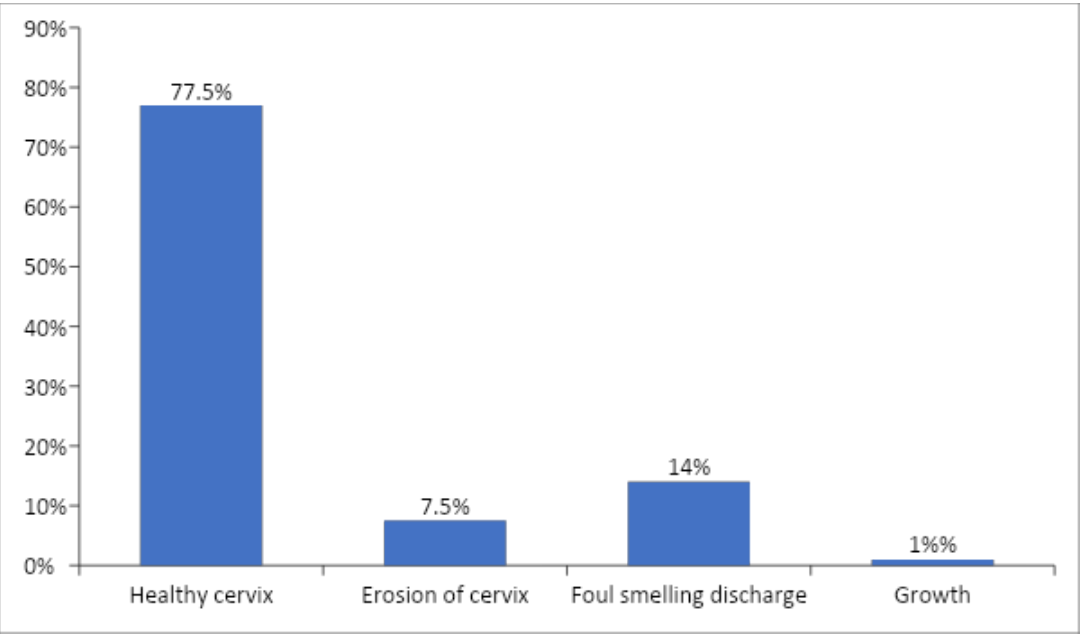
The PAP smear report revealed that 64 (32%) participants had inflammatory smear showing candidiasis and bacterial vaginosis with reactive inflammatory changes. One